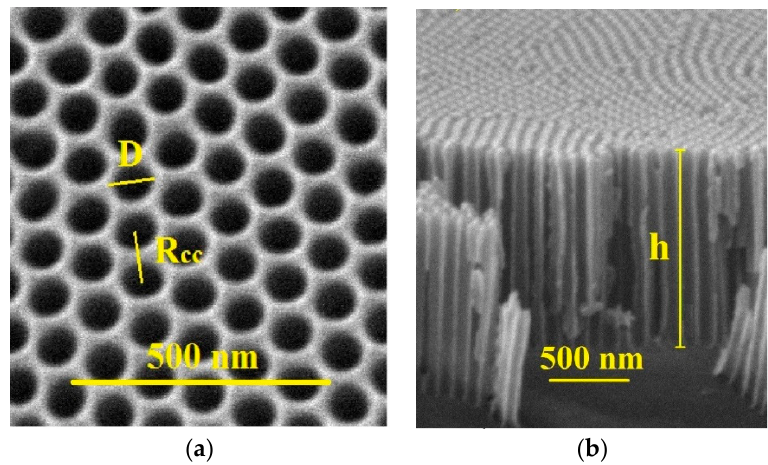
Figure 1. ( a ) Top view of the nanoporous anodic alumina membrane (NAAM) patterned platform supporting the electrostatic nanostructured capacitor (ENC) structure, showing the honeycomb symmetry acquired by the pores. Geometrical parameters are also shown, such as the distance between centers ( R CC = 105 ± 5 nm) and the diameter of the pores ( D = 65 ± 3 nm). ( b ) Side view of the NAAM showing the height ( h = 1.2 ± 0.1 µ m) of the pores as well as their parallel alignment.